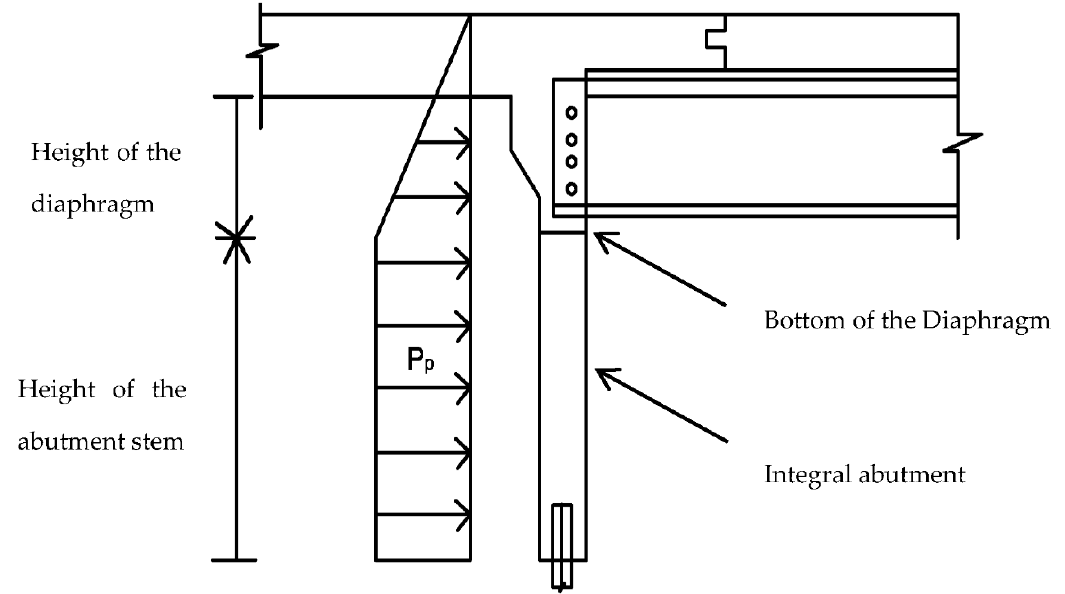
Figure A3. Design earth pressure in IABs [43].